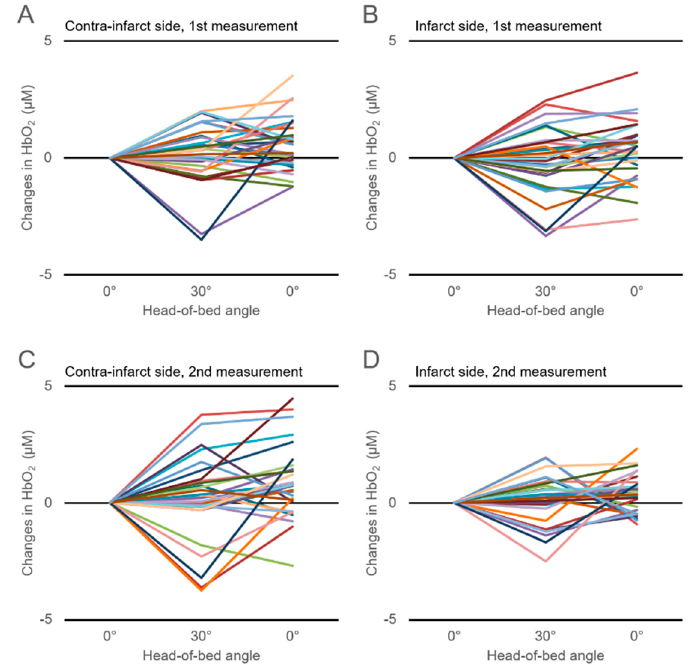
Figure 1. Time-series changes in the cerebral total hemoglobin (tHb) concentration in response to head-of-bed manipulation (from 0° to 30°) for 30 participants within 72 h of onset of acute ischemic stroke (AIS) (first measurement) on the contra-infarct (contralateral) side ( A ) and infarct side ( B ) and those measured 7–10 days after onset of AIS (second measurement) on the contra-infarct side ( C ) and infarct side ( D ).